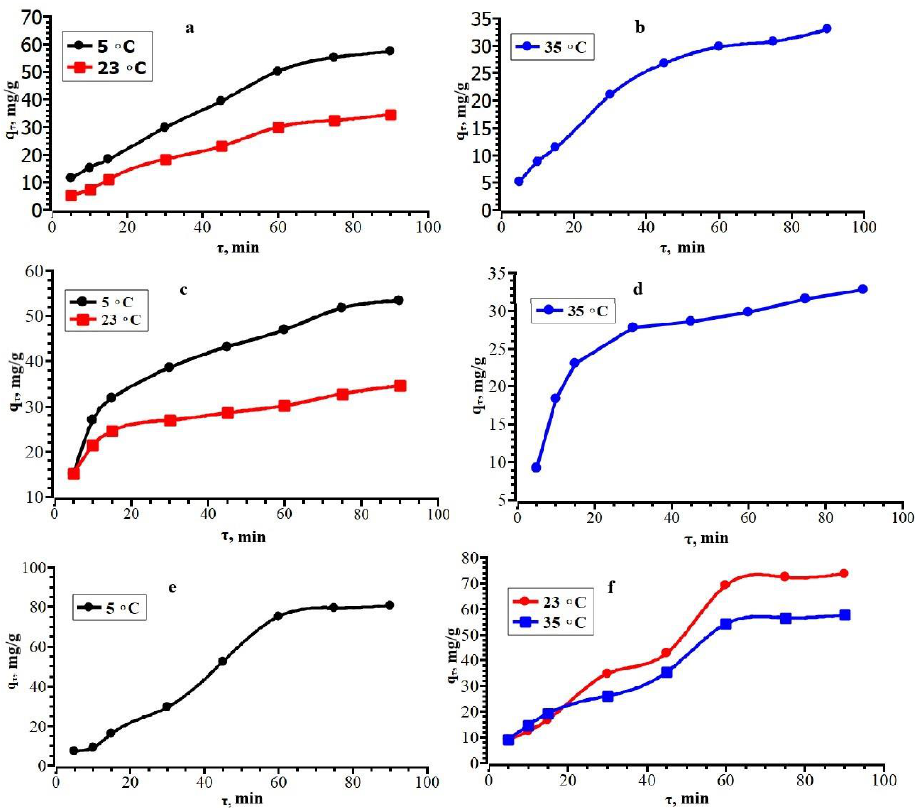
Figure 8. Kinetic curves of solid phase extraction versus contact time for CZO ( a , b ), CTX ( c , d ), and CRO ( e , f ).